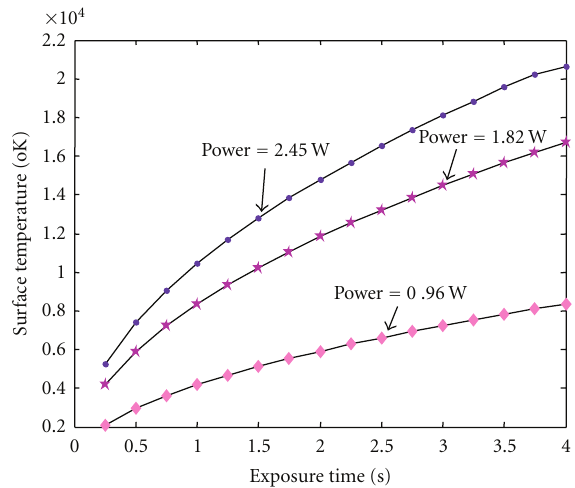
Figure 6: The laser beam exposure time versus the surface temperature.